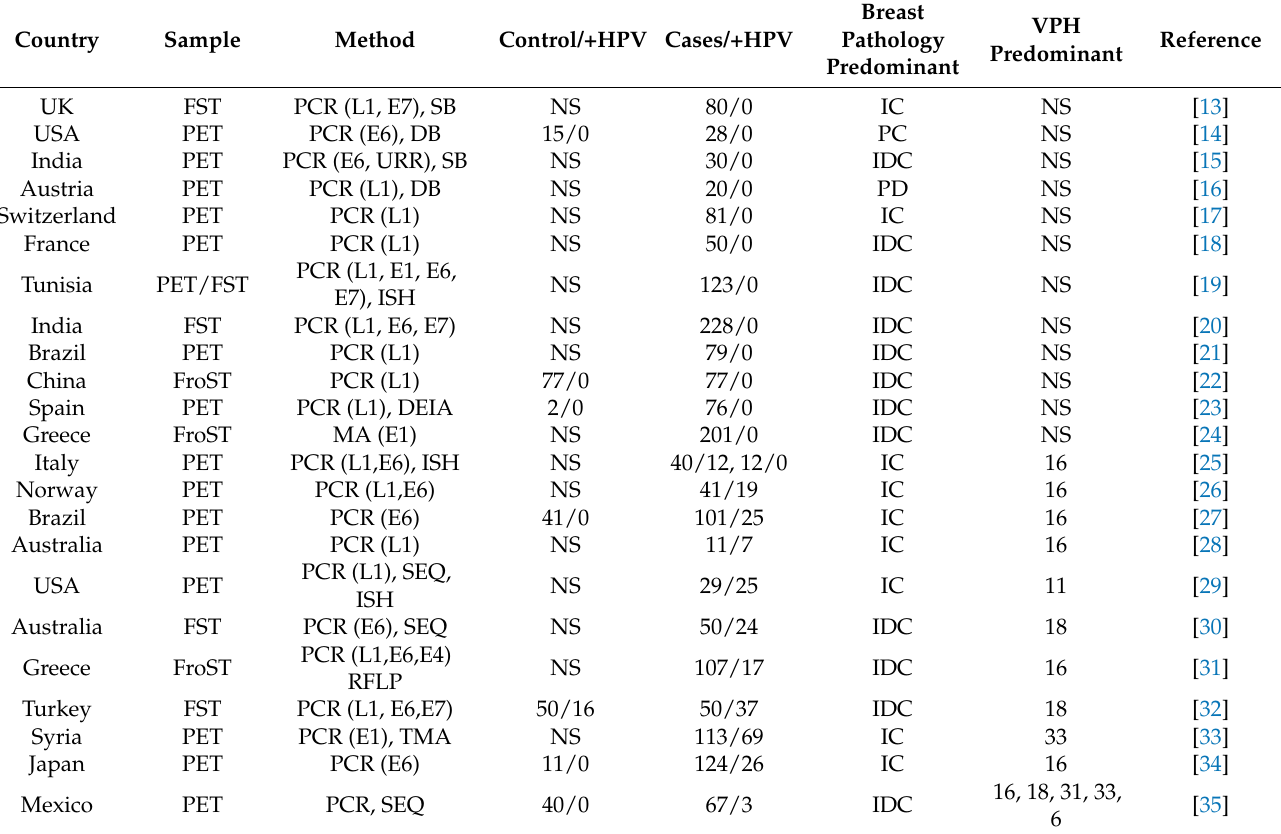
Table 1. HPV DNA found in breast cancer samples